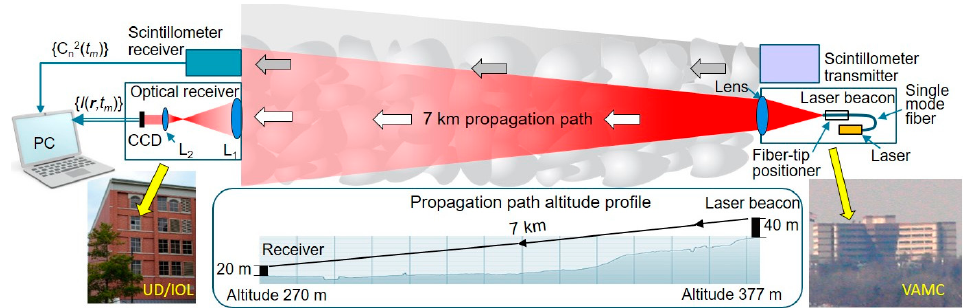
Figure 1. Notional schematic of the experimental setting used for collection of short-exposure laser beam intensity scintillation images and the corresponding values of the refractive index structure parameter 2 n C (ATM data sets) under different atmospheric turbulence conditions. The insert shows the propagation path altitude profile.